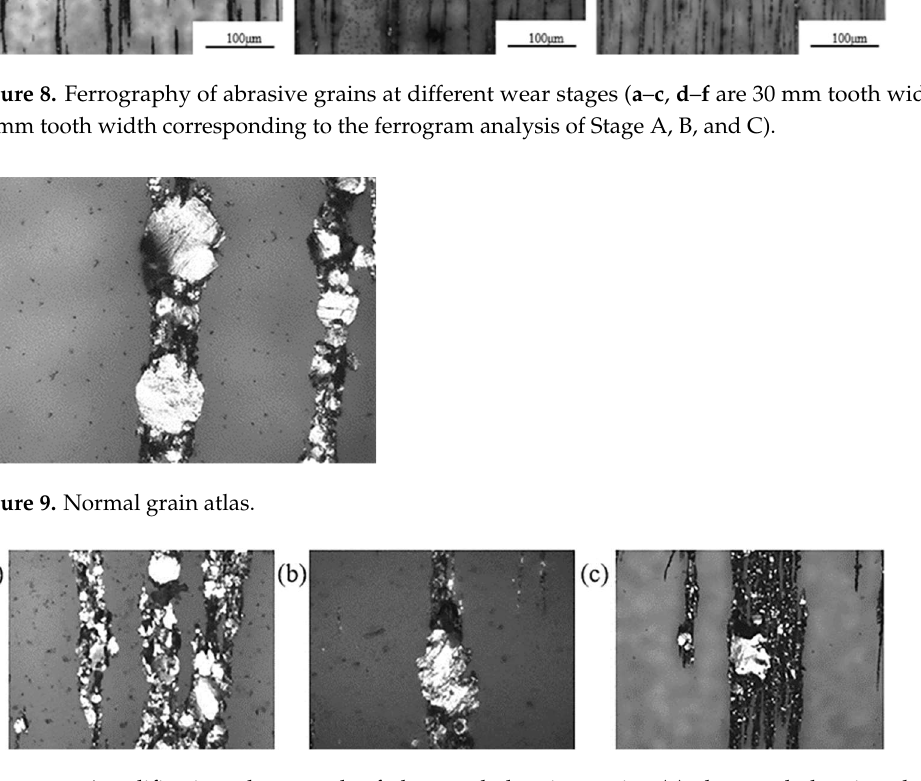
Figure 11. Variation trend of abrasive particle concentration for 10 mm gear until failure. Figure 12. Ferrography of abrasive grains for 10 mm gear at severe wear stages ( a ) abrasive parti- cle diagram of 10mm tooth width during stable wear period, ( b ) abrasive grain diagram of 10mm tooth width near failure.